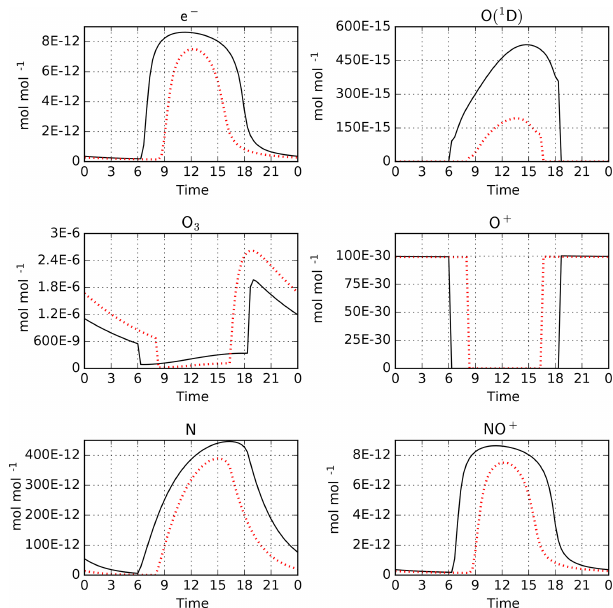
Figure 5. Model-calculated mixing ratios from an upper atmo- sphere simulation with MECCA and RADJIMT: diurnal cycles for 4 January (after 3 days of spinup) for the Equator (black) and a lat- itude of 50 ◦ N (red). Time is in hours with local noon at 12. See Sect. 3.2 for further